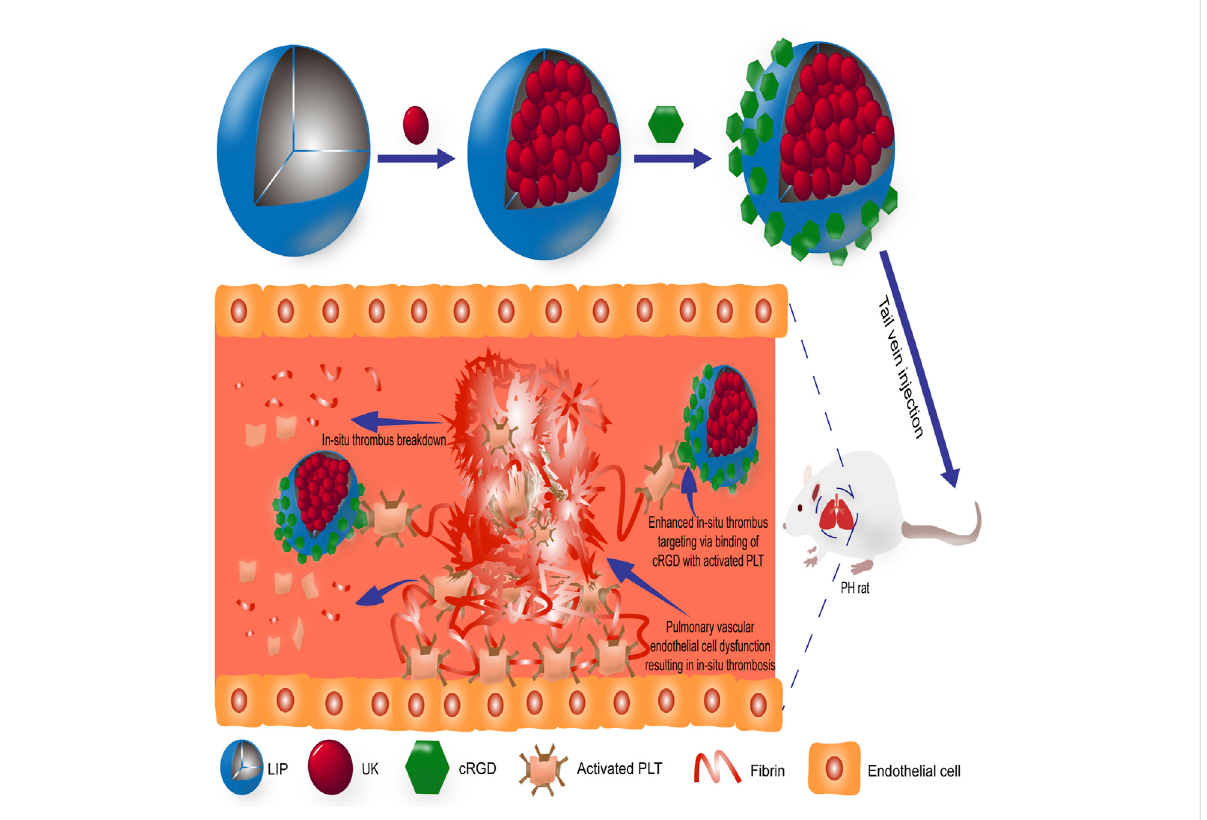
FIGURE 1 Schematic illustration of the mechanism of targeted therapy of in-situ thrombus in PH with UK-cRGD-Liposome nanoparticles. Abbreviations: PH, pulmonary hypertension; cRGD, Cyclic RGD; UK, urokinase; PLT,